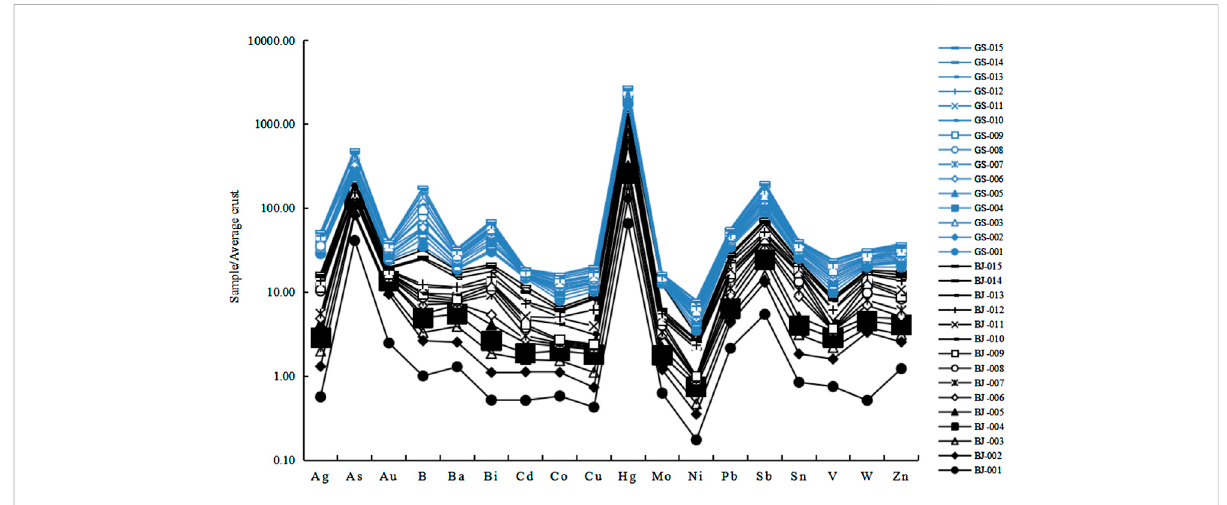
FIGURE 5 Earth crust-normalized spidergram of Au and path fi nder elements of wall rocks and altered rocks in the Hongqiggou